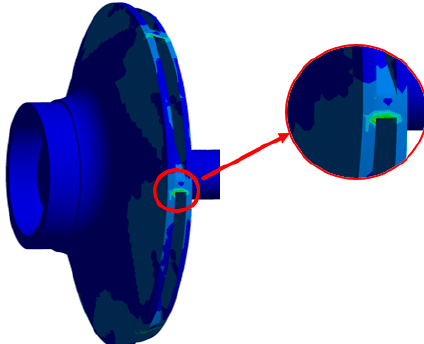
Figure 15. Maximum stress point diagram of impeller under 0.4 Q d working condition.